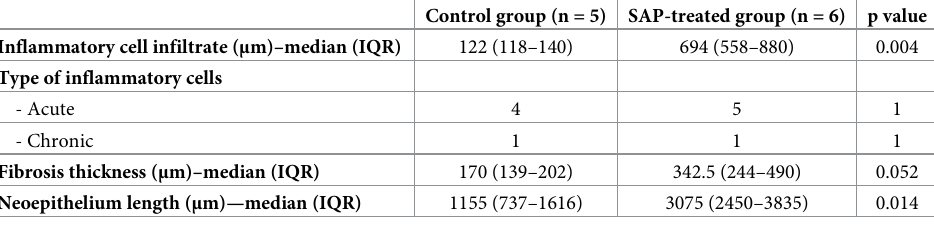
Table 2. Pathology findings in the SAP treated and control groups at day 14 after esophageal circumferential endoscopic submucosal